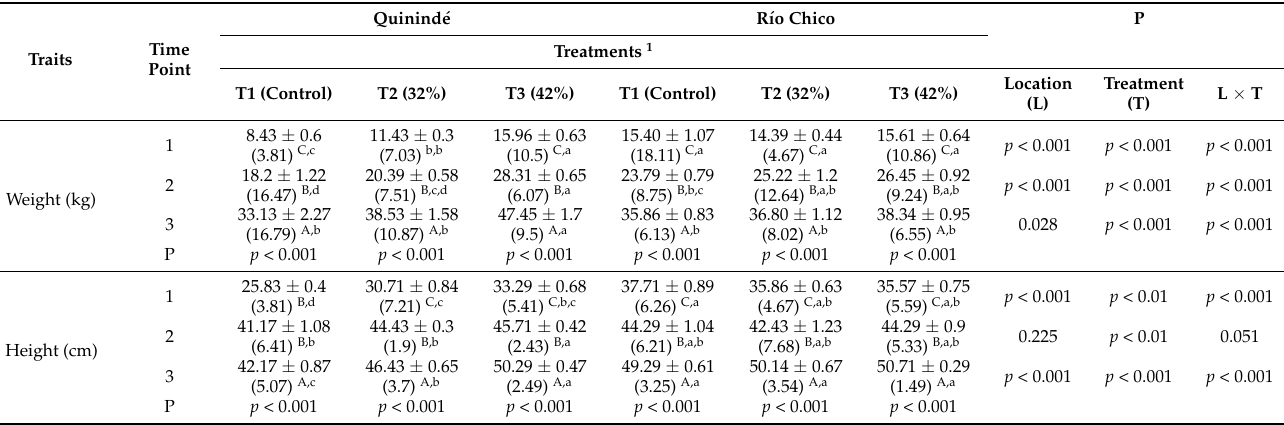
Table 4. Productive performance (mean ± standard error (coefficient of variation)) of growing back- yard pigs fed with different formulations from two locations in Ecuador (Quinind é and R í o